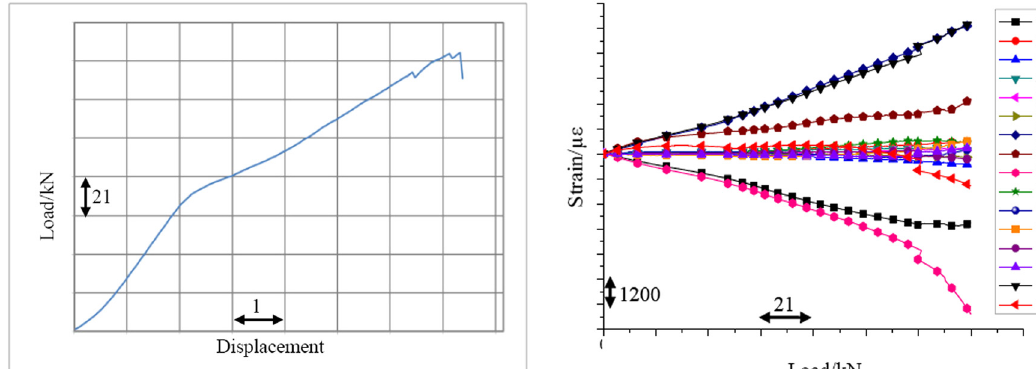
Figure 8: b3 - type test curve.